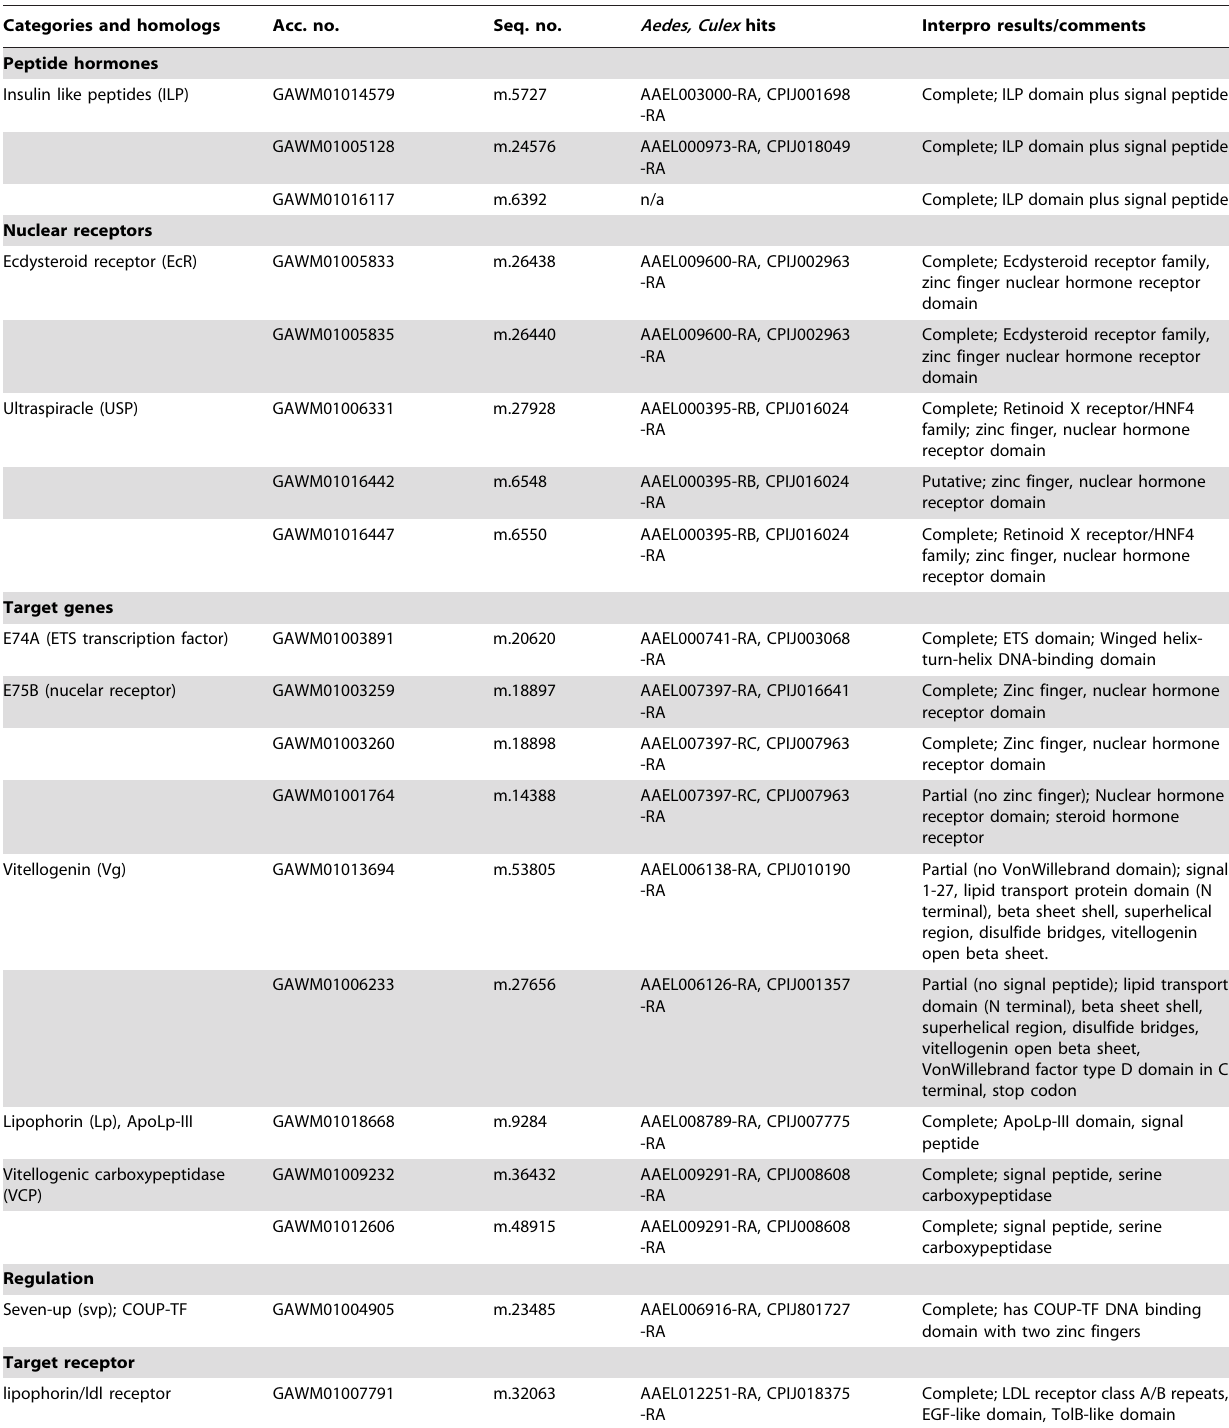
Table 1. Genetic components of vitellogenesis in C. sonorensis